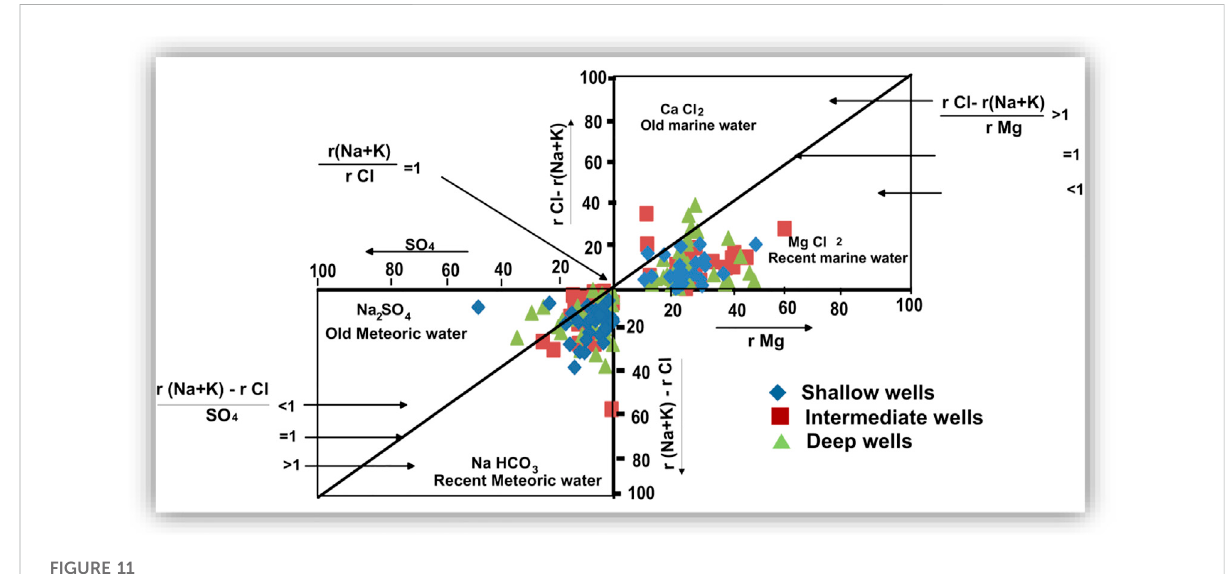
FIGURE 11 Sulin ’ s diagram illustrates the genetic types of the groundwater samples.